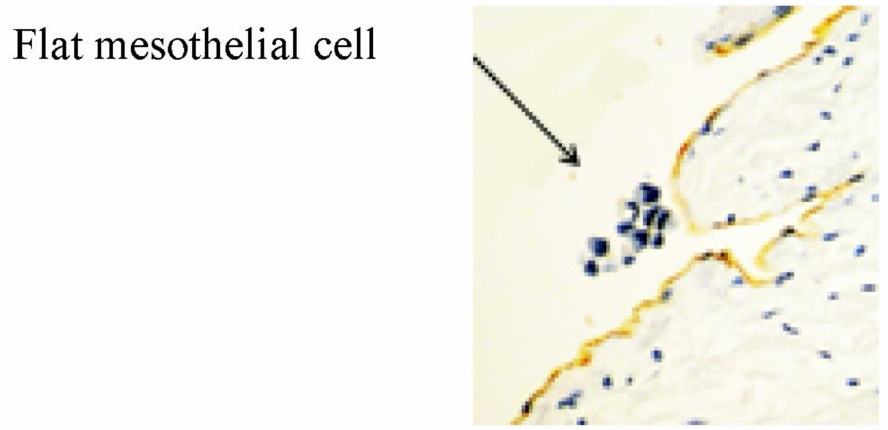
Figure 13. Cluster of cancer cells attached to mesothelial cells of the pelvic peritoneum that was obtained from gastric cancer patients by peritonectomy (D2-40 immune staining). Integrin L2 and 2 expressed on PFCCs heterotopically bind with PCAM-1 and VCAM-1 from mesothelial cells